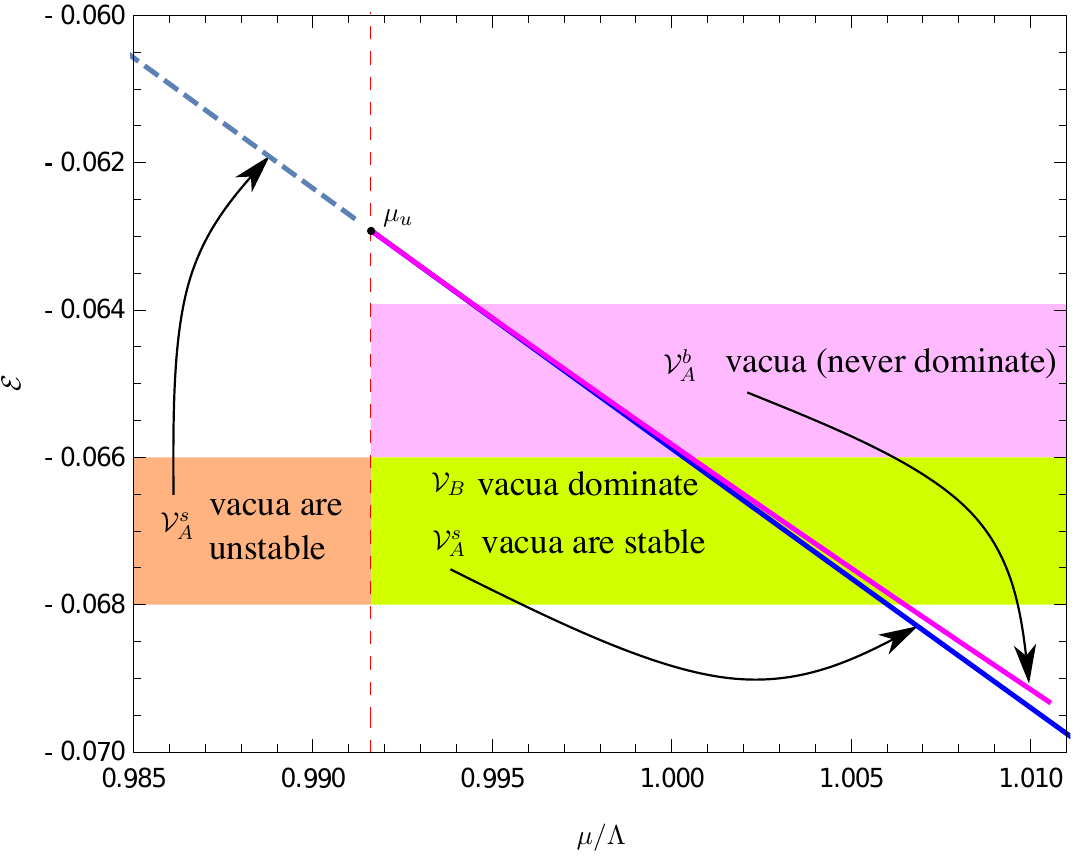
b vacua (solid magenta curve) extends for µ > µ u , see (5.4), A V